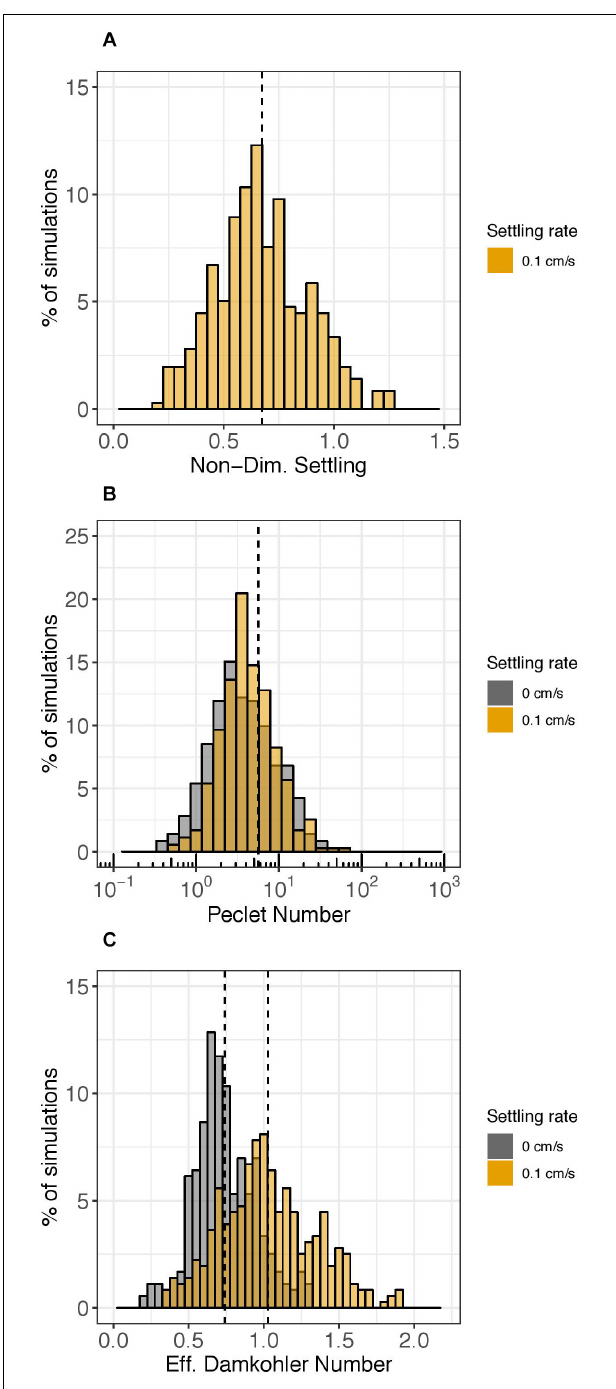
FIGURE 5 | Histograms of select non-dimensional numbers. The y -axis represents the percent of simulations over the year ( n = 358 for each settling rate case) that had the corresponding value on the x -axis after 1 day of the particle tracking simulation. Gray shading represents simulations without settling ( w s = 0 cm s − 1 ) and orange shading represents simulations with settling ( w s = 0.1 cm s − 1 ). The non-dimensional settling rate is plotted in Panel (A) . The Pèclet number (log-scale) is shown in Panel (B) and the effective Damköhler number is shown in Panel (C) . Vertical dashed lines show mean values; in Panel (B) , the two vertical lines